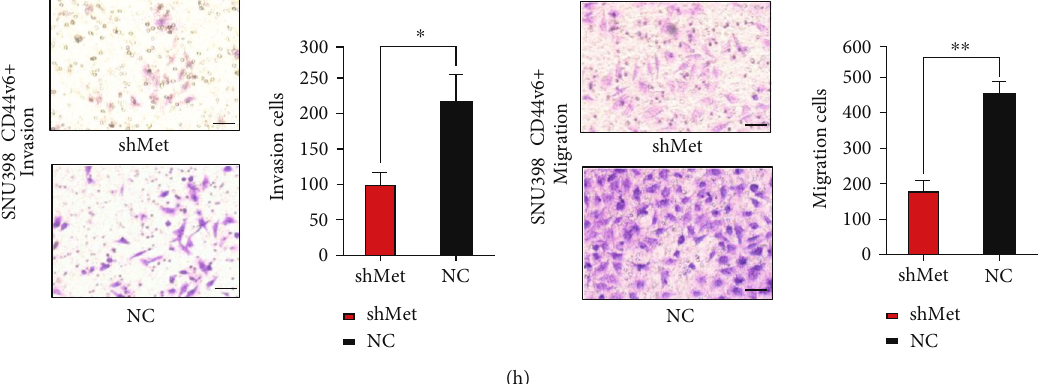
Figure 2: The HGF/MET signaling pathway contributes to maintenance of stemness in CD44v6+ HCC Cells. (a) Western blot analysis of the Met protein levels in 18 paired HCC tissues and adjacent nontumor tissues selected randomly. β -Actin was used as a normalized control. (b) Kaplan – Meier survival analysis of overall survival were compared according to the expression levels of the Met in HCC tissues. Patients with Met expression median survival = 32 months vs. 48 months, log-rank test, n = 53 , ∗ p = 0 : 0415 . The immunohistochemical staining shows the expressions of Met in surgical specimen from patients with HCC. The expression of Met in tumor tissue was signi fi cantly higher than in adjacent nontumor tissue. Scale bar, 20 μ m. (c) The expression of EMT-related genes, including Snail1, Slug, and Twist in CD44v6+ and CD44v6- cells. β -Actin was used as a normalized control. (d) The expression of Met and the stemness relative genes, including Nanog, Sox2, and Oct4 in CD44v6+ and CD44v6- cells. β -Actin was used as a normalized control. (e) shMet CD44v6+ cells and scrambled cells were subcutaneously injected into the BALB/c mice ( n = 5 in each group). Black arrow means NC group, red arrow means Met shRNA group. The tumor volume from each group was tested. For statistical analysis, ∗ p < 0 : 05 , ∗∗ p < 0 : 01 , t -test. The representative images of IHC staining of Met in NC and shMet group tumor tissues. Bars: 200 μ m. (f) The representative images of spheres and histogram analysis in indicated cells. Scale bar, 200 μ m. ∗ p < 0 : 05 , t -test. (g) The representative images of the wound-healing experiment and histogram analysis in indicated cells. Scale bar, 100 μ m. ∗∗∗ p < 0 : 001 , t -test. (h) Representative images of transwell migration and invasion in indicated cells. Scale bar, 200 μ m. ∗ p < 0 : 05 , ∗∗ p < 0 : 01 , t